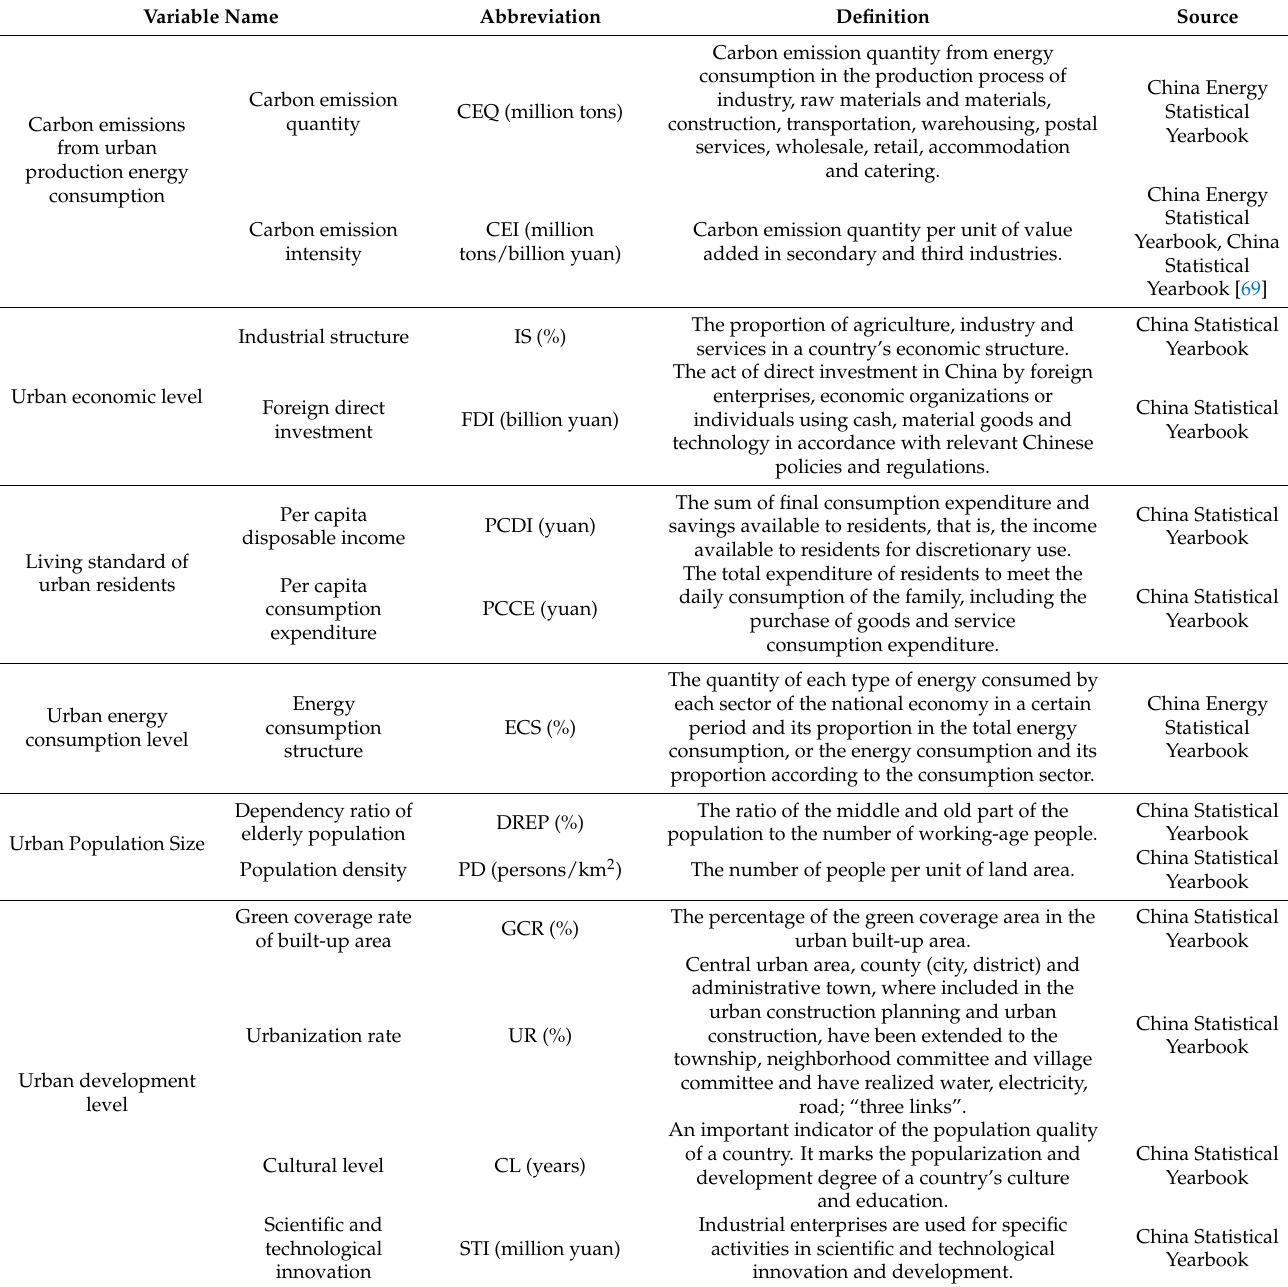
Table 1. Abbreviations, definitions, and data sources for variables.